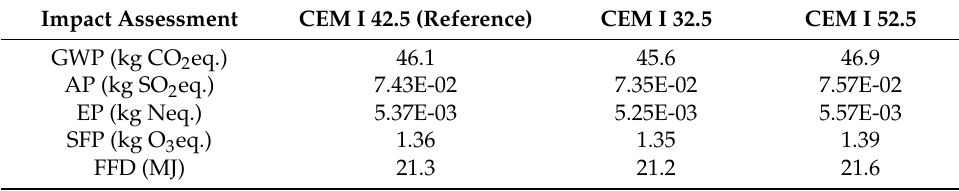
Figure 14. Sensitivity analysis results of using di ff erent cement grades. Table 11. E ff ect of the cement grade on the di ff erent environmental-impact